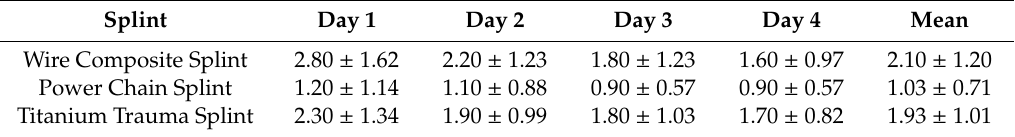
Table 3. Sensitiveness of splinted